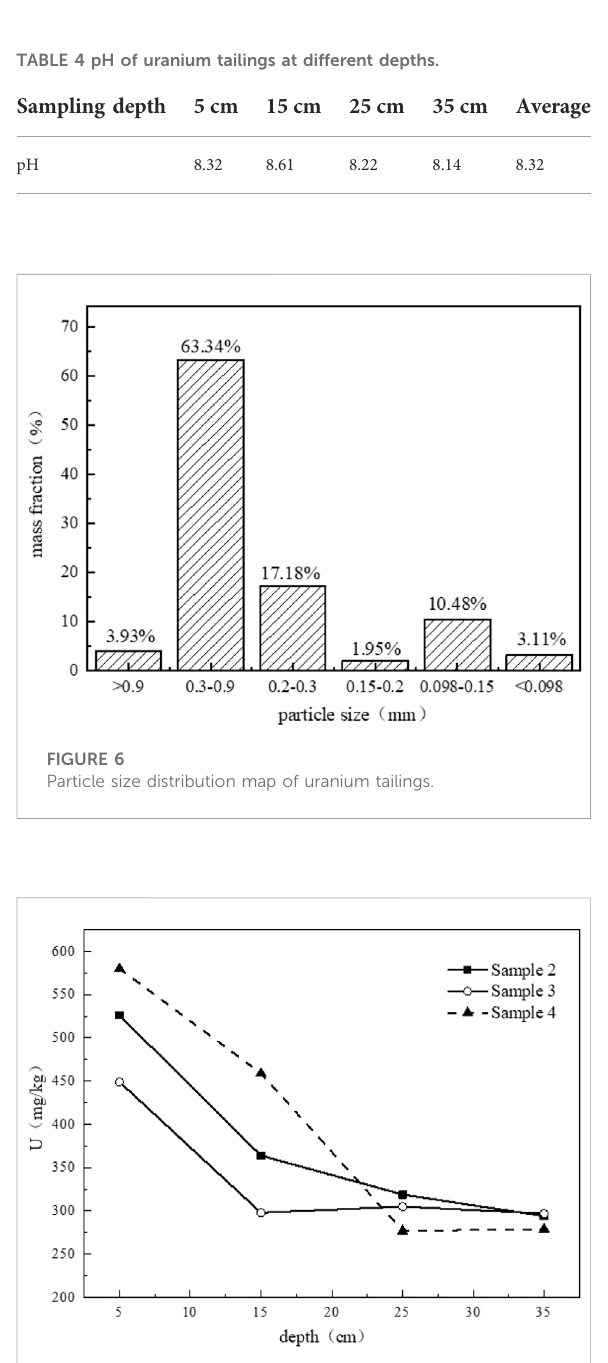
FIGURE 7 Distribution map of uranium content in tailings at different.